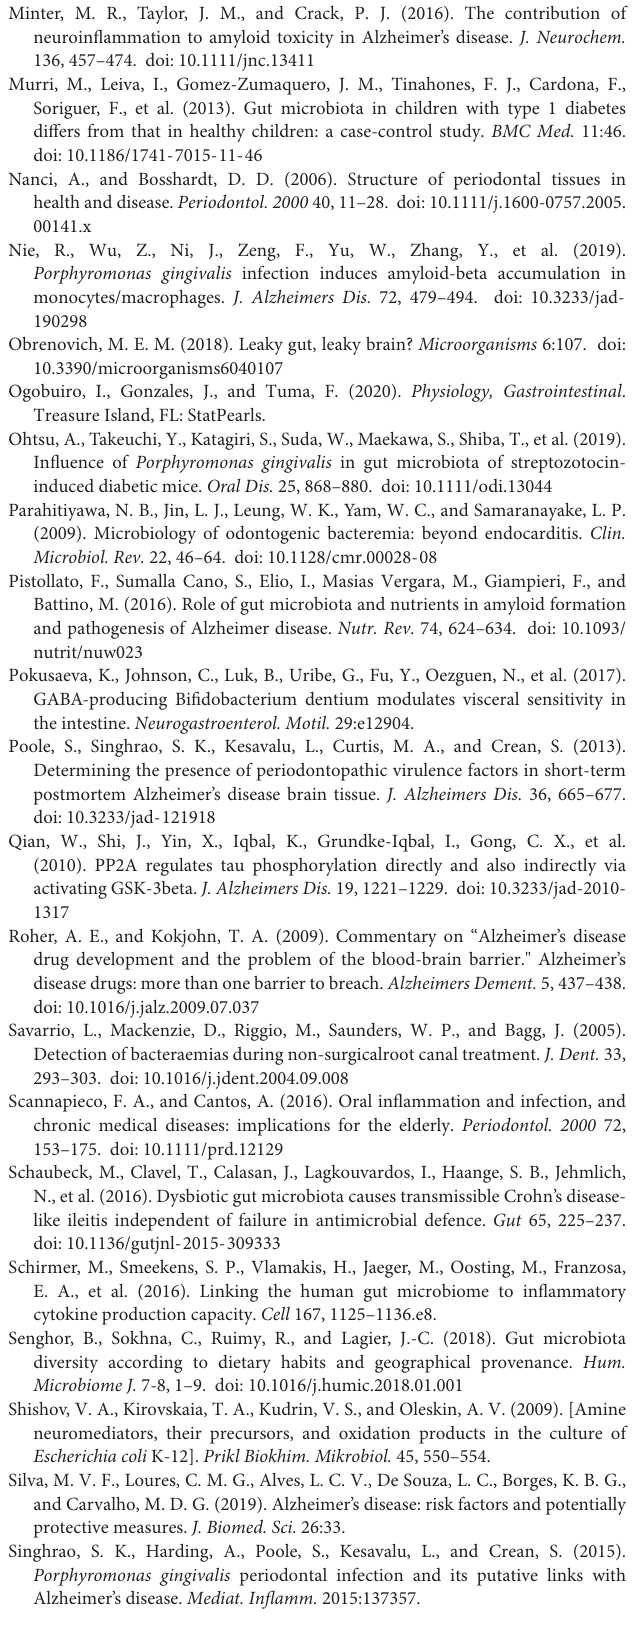
Frontiers in Cellular Neuroscience |